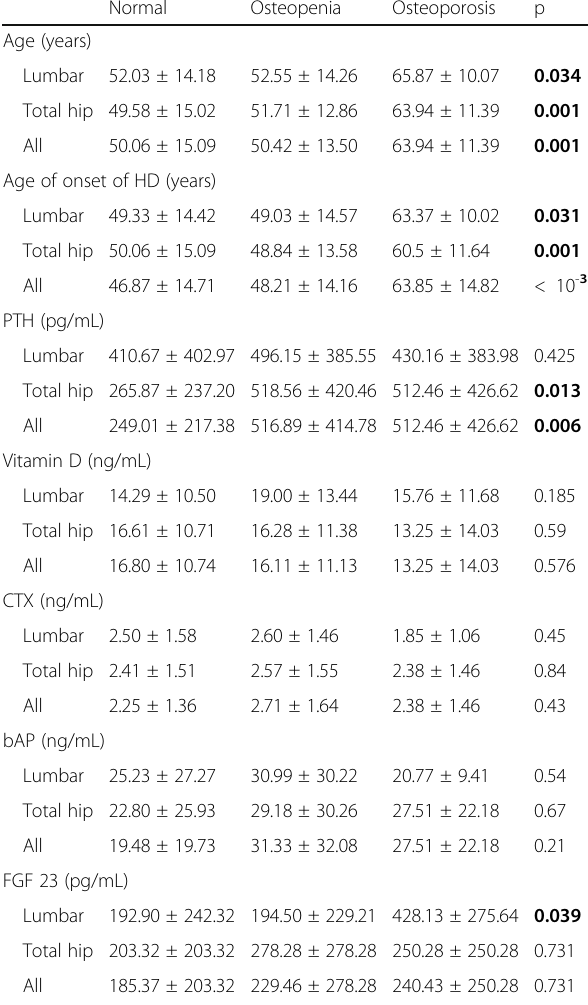
Table 4 Comparison of clinical and biological characteristics between patients with and without